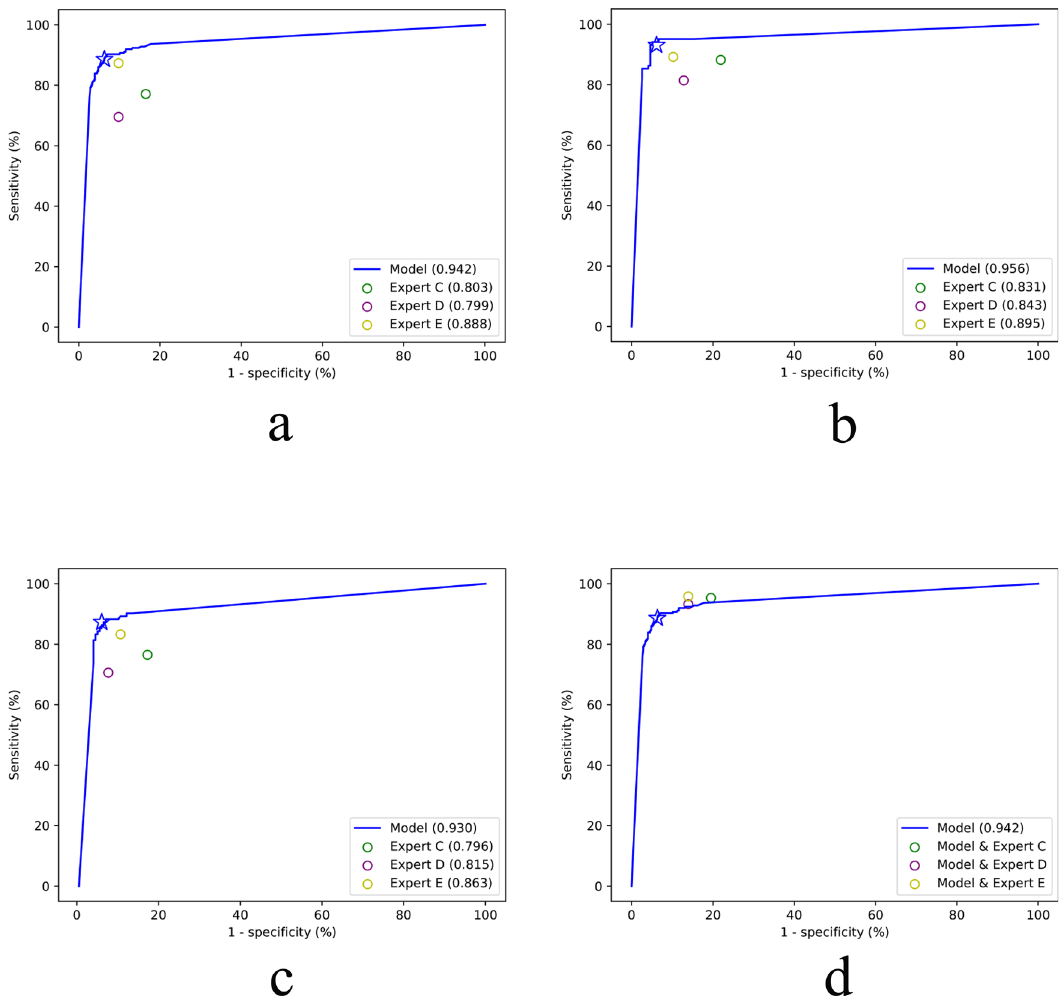
Fig. 2 The performance of the ensembled deep learning model, human experts, and the combinations of model and humans for the diagnosis of biliary atresia on the external validation dataset. a The ROC curve of the model at the image level. b The ROC curve of the model at the patient level based on majority vote. c The ROC curve of the model at the patient level based on single image with best image quality for each patient. d The performance of the combined deep learning model and human expert (circles) at the image level. The blue star represents the performance of the model with the default threshold (0.5) to binarize outputs of the model. Source data are provided as a Source data fi le. ROC receiver operating